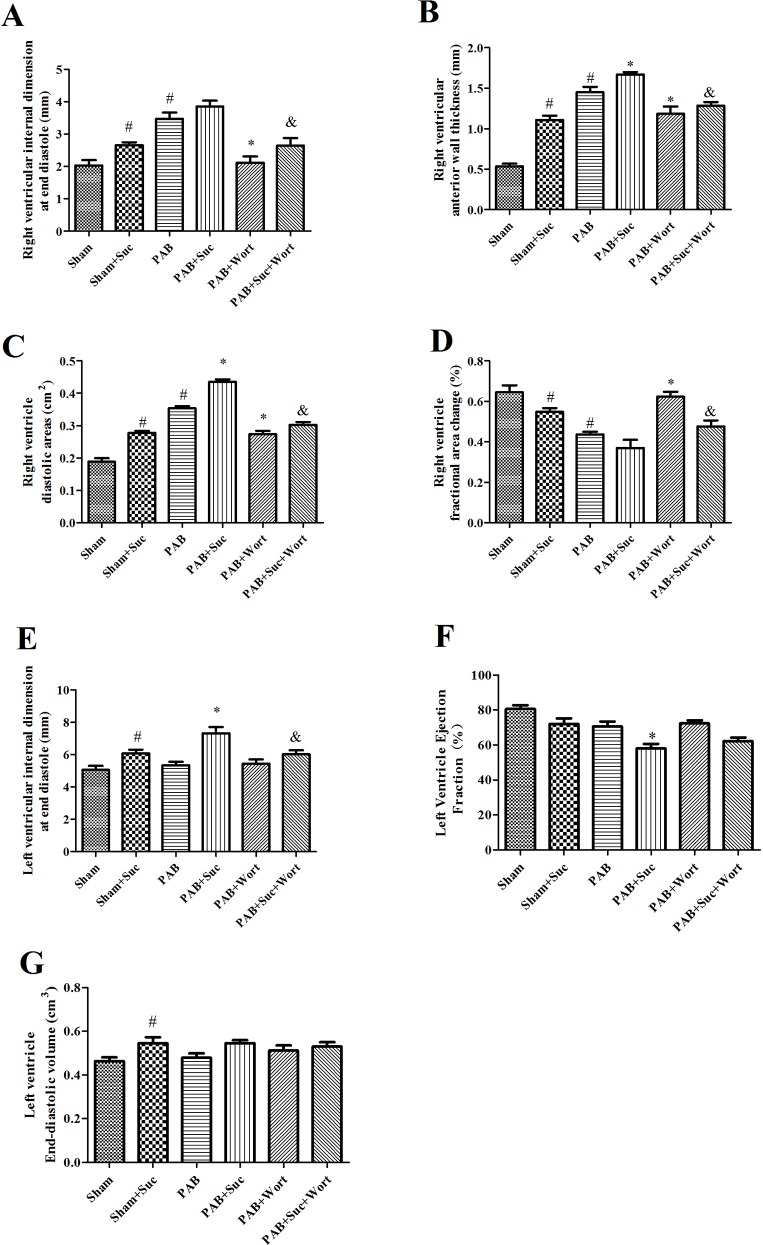
Echocardiographic data of RV and LV in each group.A: RV internal dimension at end diastole (RVIDd) in each group (n = 8). B: RV anterior wall thickness (RVAWT) in each group (n = 8). C: RV diastolic areas (RVDA) in each group (n = 8). D: The RV fractional area change (RVFAC) in each group (n = 8). E: Left ventricular internal dimension at end diastole (LVIDd) in each group (n = 8). F: Left ventricle ejection fraction (LVEF) in each group (n = 8). G: Left ventricle end-diastolic volume (LVEDV) in each group (n = 8); #P<0.05 compared to the sham group; *P<0.05 compared to the PAB group.